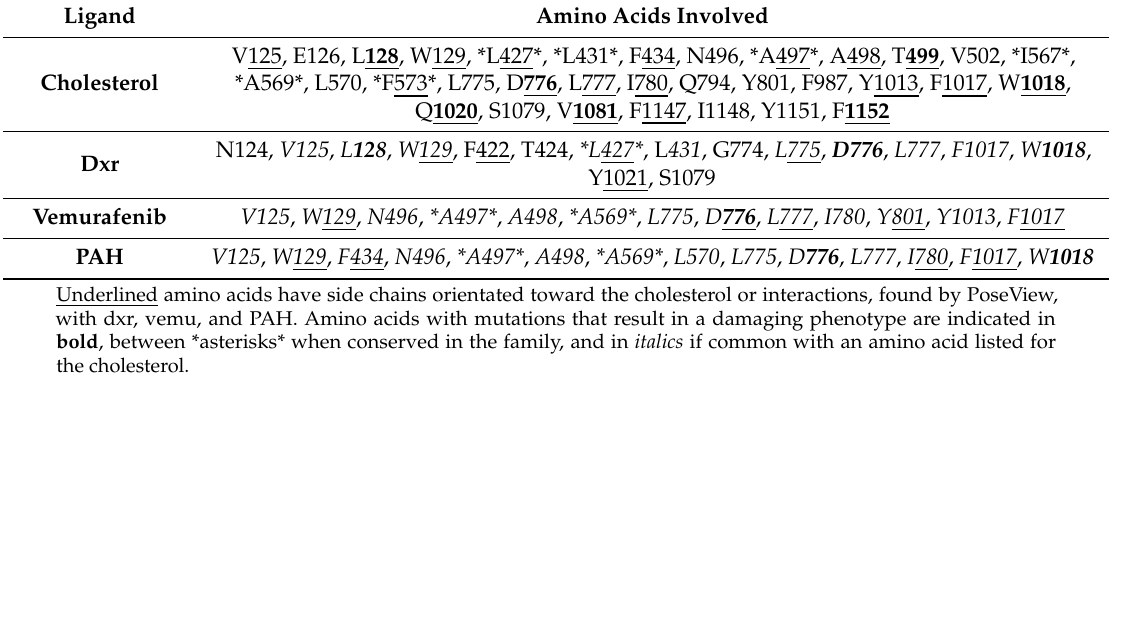
Table 3. List of amino acids within a radius of 6Å of a ligand in the best docking pose.